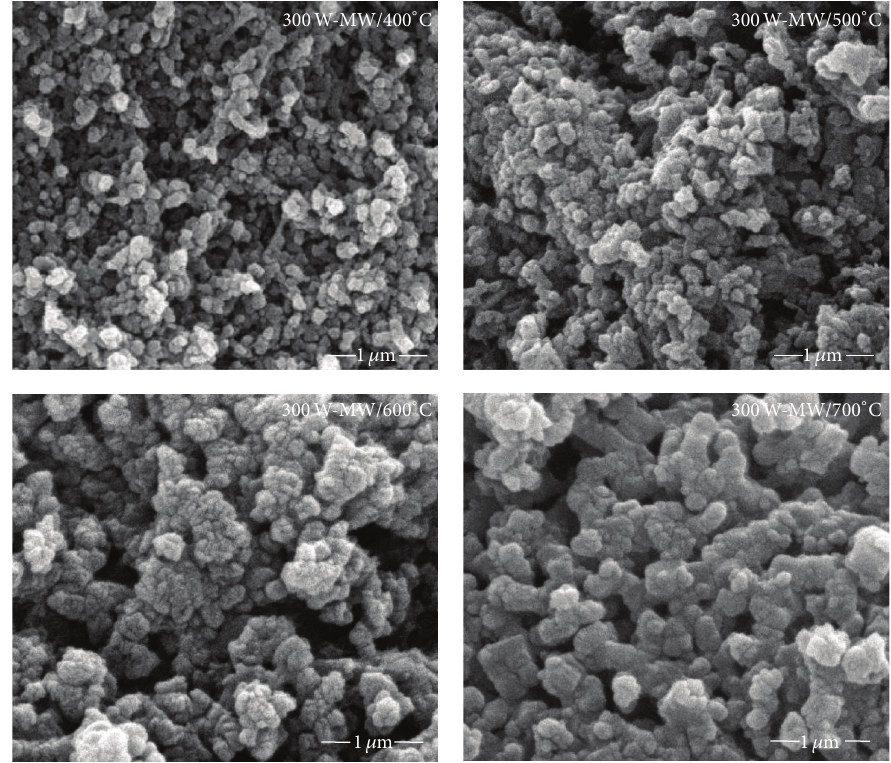
Figure 6: SEM micrographs of vanadium oxide powders prepared by the microwave heating at 300 W for 15min and calcination at temperature of 400–700 ∘ C for 1h.